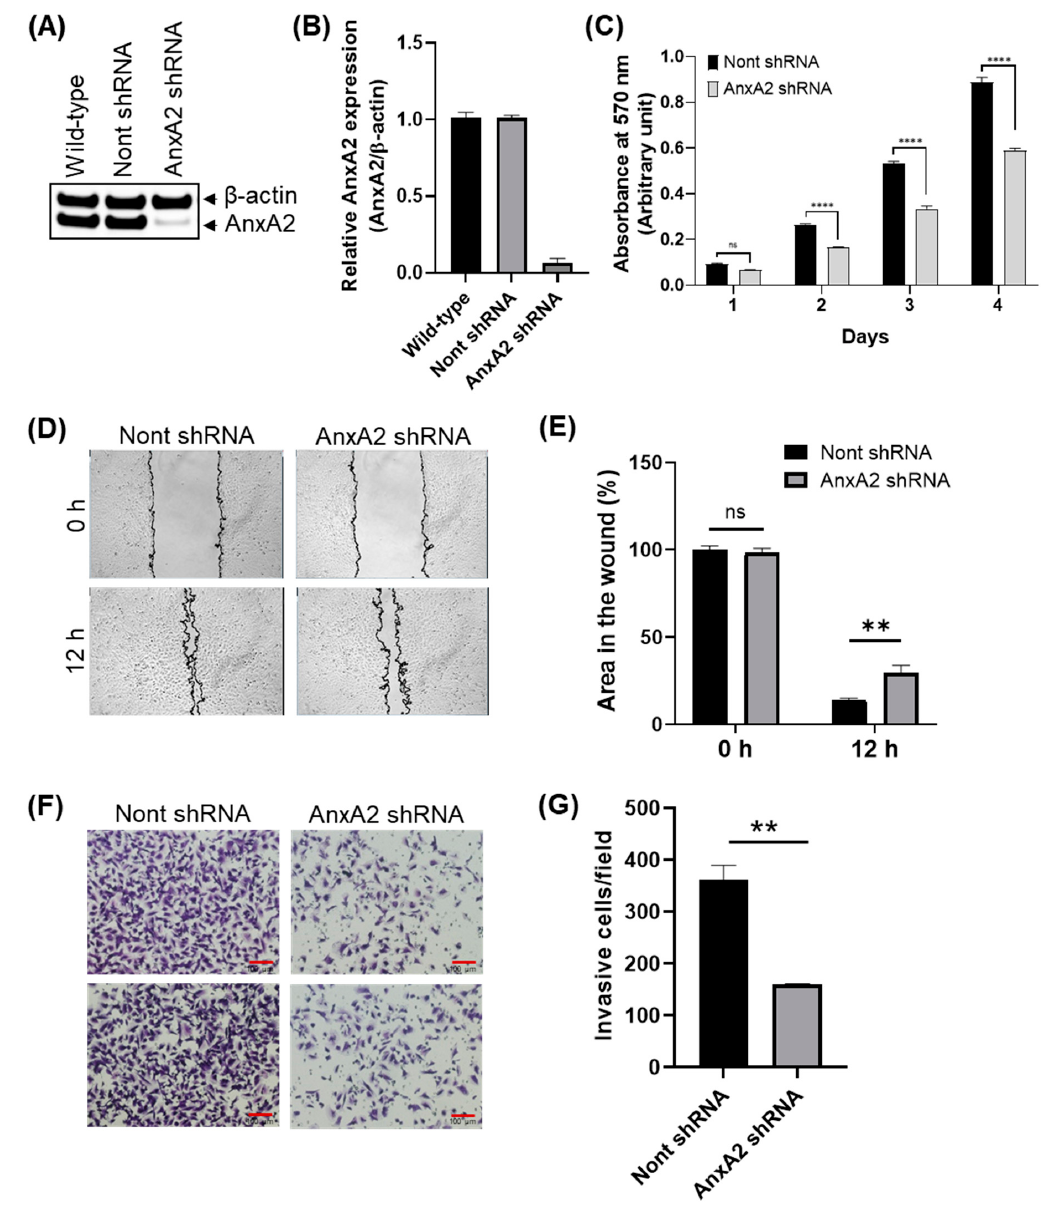
Figure 6. Effect of AnxA2 depletion on proliferation, migration, and invasion in T24 bladder cancer cells. ( A ) AnxA2 was knockdown in human bladder cancer cells using shRNA. Immunoblot analysis showed that AnxA2 expression was efficiently knockdown by AnxA2 shRNA in T24 cells. β‐ Actin was used as a loading control. ( B ) The intensity of AnxA2 bands was determined by densitometry and normalized by loading control. The bar graph represents the fold decrease in AnxA2 in shRNA knockdown T24 cells compared with control T24 cells. ( C ) bladder cancer cells were seeded in 96 ‐ well plate at the density of 500 cells/well in McCoy’s 5a medium for incubated for different time periods. MTT analysis was performed as described in material and methods to assess the cell pro ‐ liferation. ( D ). Representative images from wound healing migration assays performed with the AnxA2 knockdown T24 cells. ( E ) Bar graph showing the percentage of wound closure after 12 h of wound formation. ( F ) Representative images from transwell invasion assay performed with the AnxA2 knockdown T24 cells. ( G ) Bar graph showing the number of invaded cells. Data are pre ‐ sented as mean ± SEM, ns , non ‐ significant; **, p < 0.01; ****, p < 0.0001. Uncropped Western Blot of (A) is available in Figure S1.